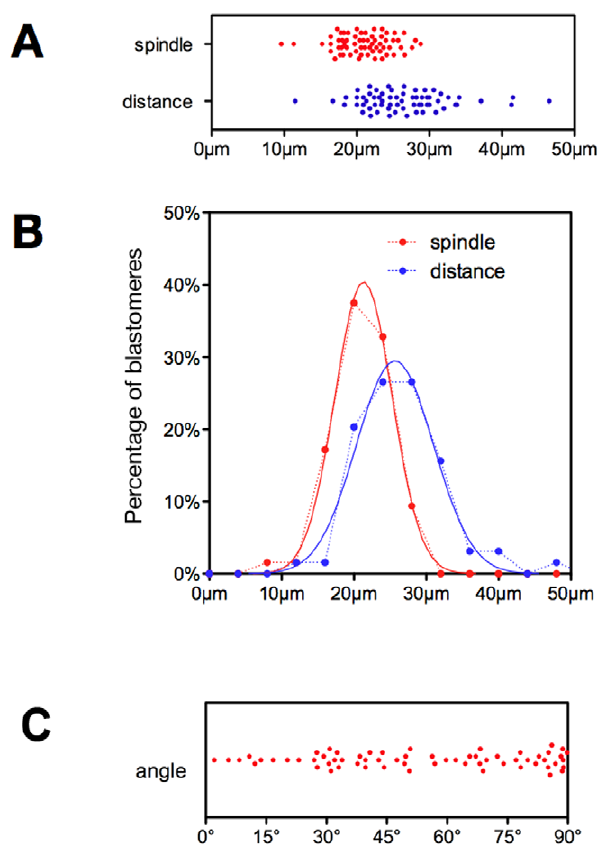
Figure 3. Dispersed distribution of the angle between the spindle and the radial axis. Distributions of the spindle size (A-B, red), distance from the centroid (A-B, blue) and a angle value (C). In B, the same populations (spindle size and distance from the centroid) were plotted as a frequency distribution (every 4 m m). The dashed lines correspond to our data and the plain lines to the curve fits.